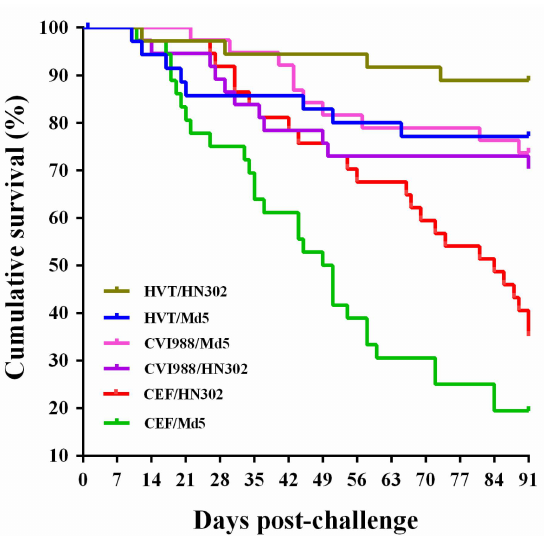
Figure 3. Survival curves of the MD-vaccinated and unvaccinated birds challenged with viruses HNLH302 or Md5 over the 91-day experimental time period. For each of two experimental groups, 1-day-old birds were separately vaccinated with CEFs containing 2000 PFU of HVT or CVI988 viruses by subcutaneous injection, while for the positive controls, two groups of birds were vaccinated with an equal volume of mock-infected CEFs. At 7 days of age, each of MD-vaccinated or mock control groups were separately challenged by HNLH302 or Md5 viruses (1000 PFU per bird) by intra-abdominal inoculation. Early deaths due to intra-abdominal infection adverse effects and birds sacrificed for body weighting and immune organ collections were excluded for data